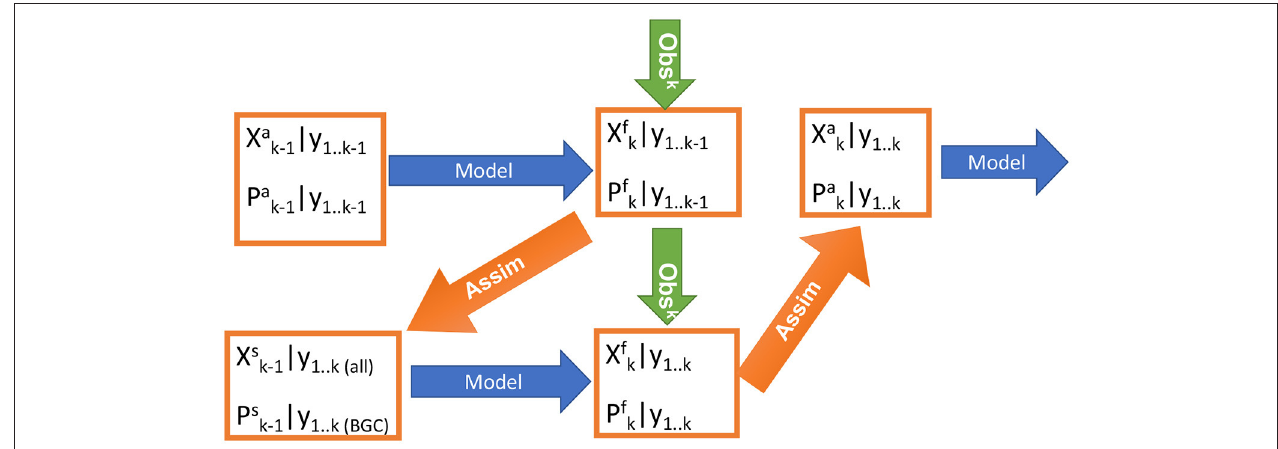
FIGURE 1 | Schematic diagram of the steps of the dual one step ahead (DOSA)